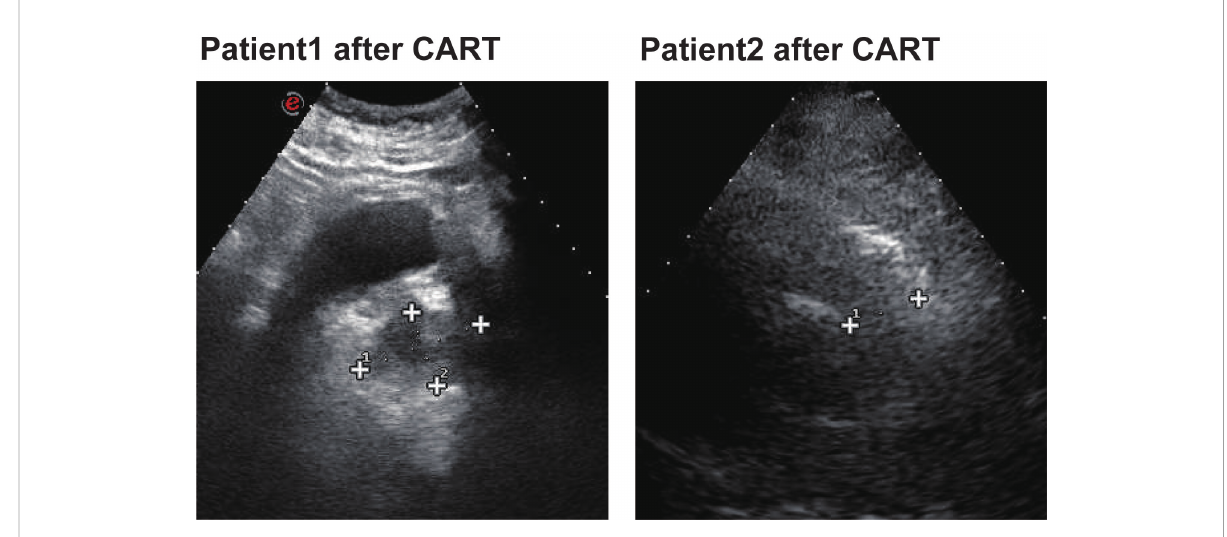
FIGURE 2 Ultrasound images of the thyroid gland after CART treatment in two